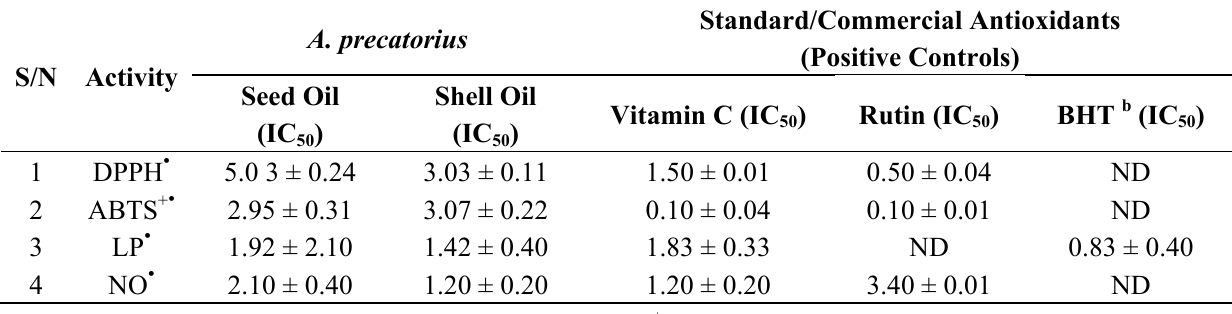
Table 1. Antioxidant capacity of essential oils of A.precatorius (mg/mL).